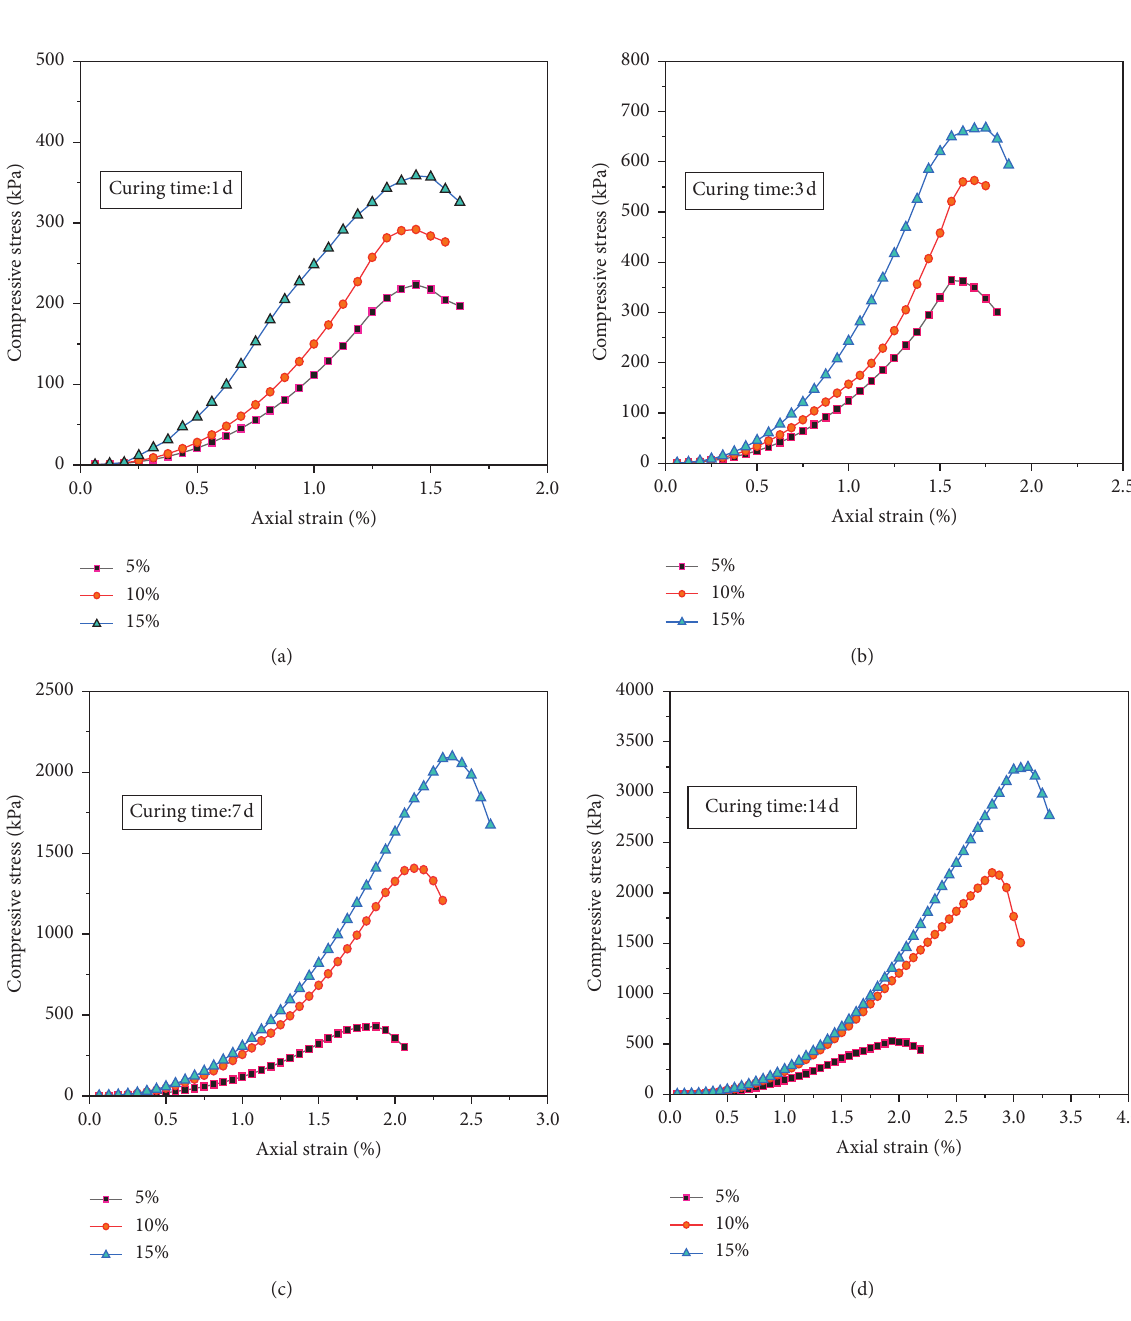
Figure 4: Stress-strain curves for UCS test